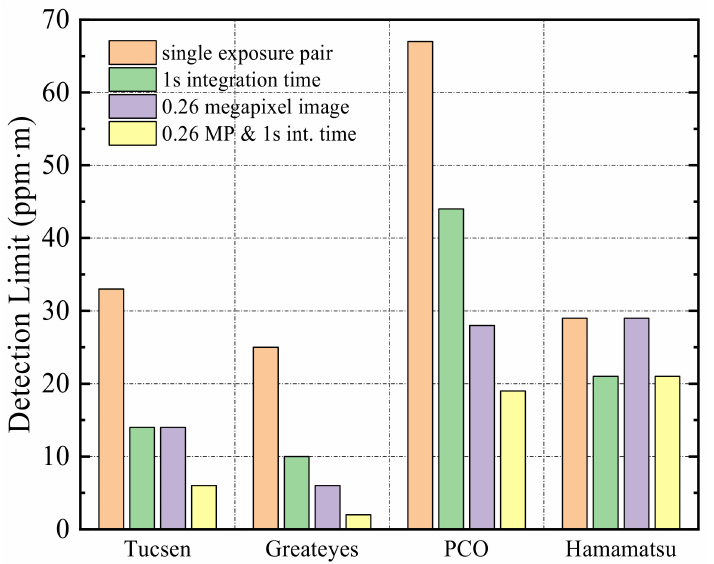
Figure 15. Detection limits of different camera systems with a detection distance of 5 km and atmospheric visibility of 50